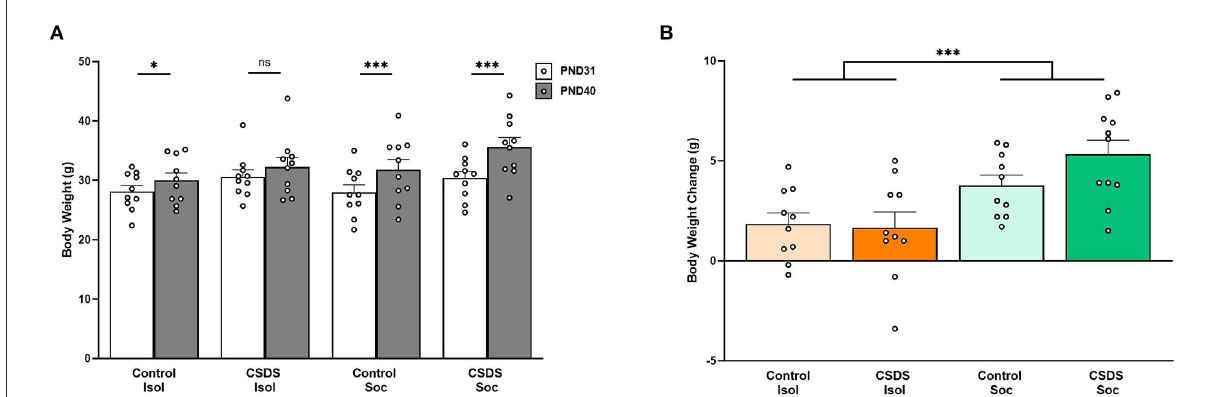
FIGURE2 Effects of social isolation and CSDS on body weight and body weight gain. (A) Body weight measured before the first social defeat session on PND31 and after the last social defeat session on PND41. (B) Body weight gain (body weight on PND40 – body weight on PND31). Color scheme follows Figure 1 where orange = isolated; green = group-housed; dark colors = chronic social defeat; light colors = control (no chronic social defeat). Data are presented as mean ± SEM and dots represent individual data. * p < 0.05; *** p <